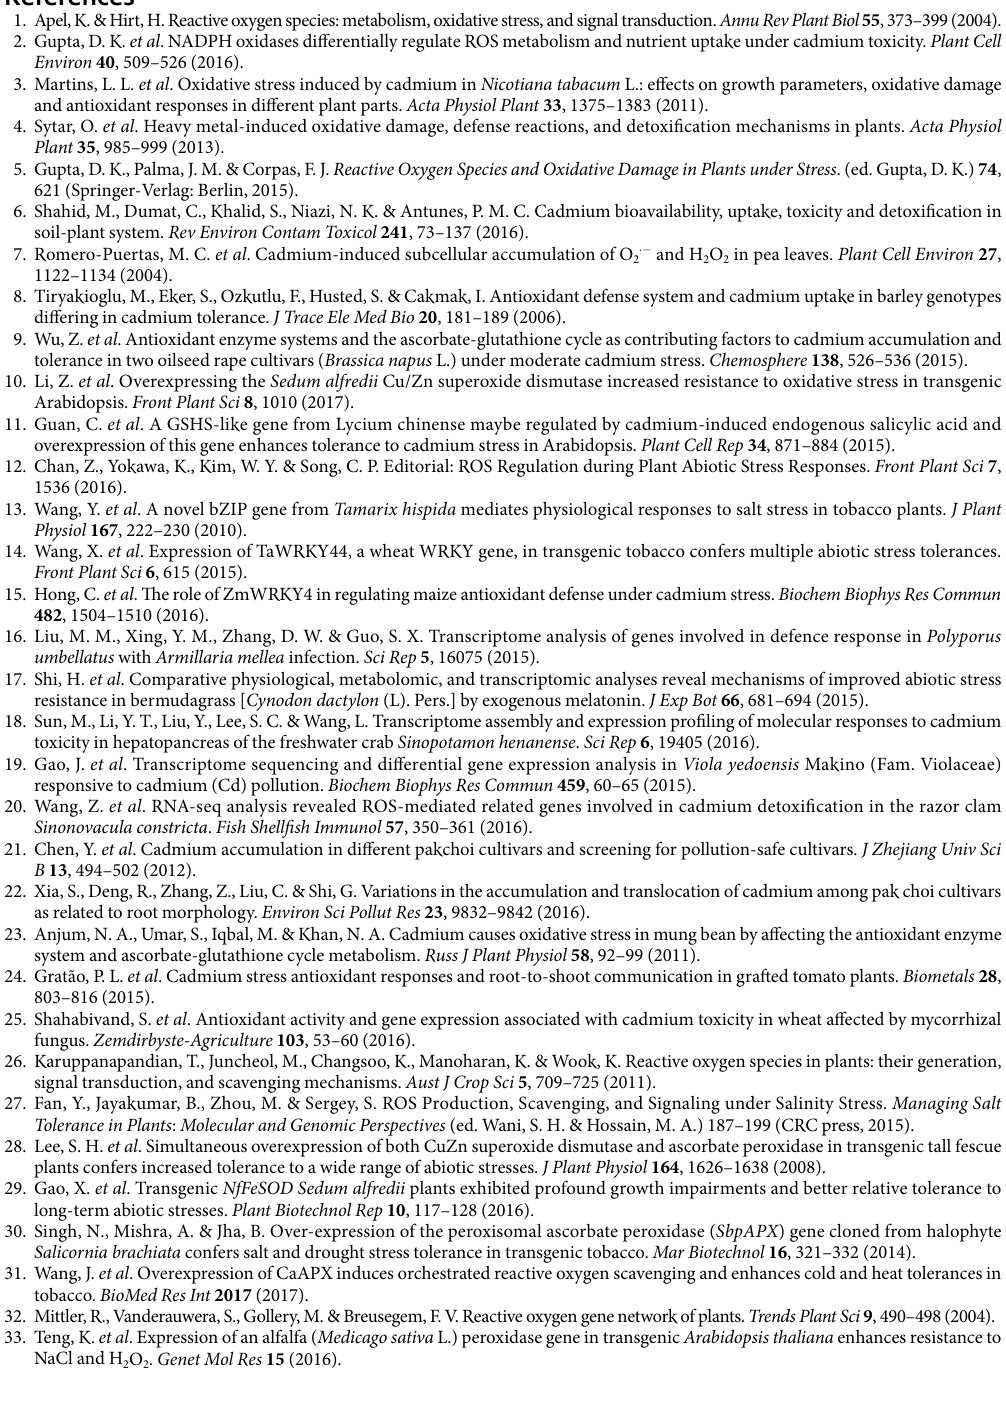
(Table S7). The relative expression level of the selected genes using the Actin gene as the internal control gene was calculated using ratio = 2 −ΔΔ C T . Data deposition. The four data sets of RNA-sequencing are available at the NCBI Short Read Archive